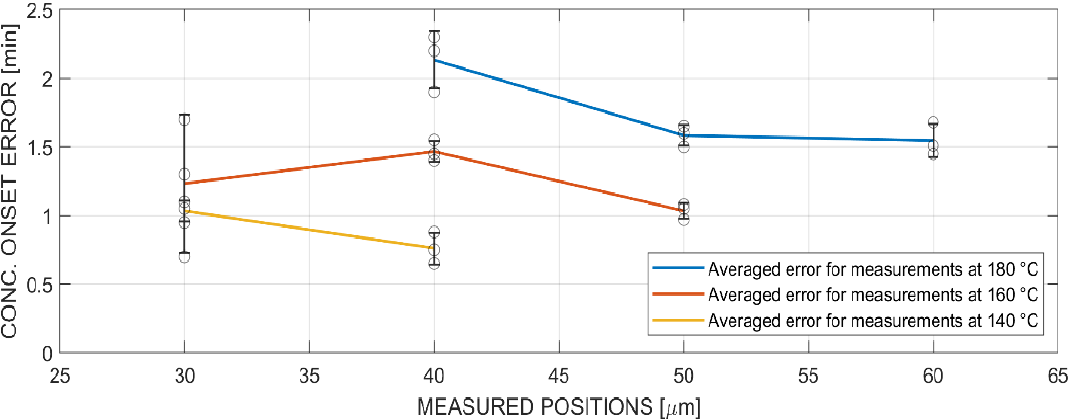
Figure 14. Comparison of the concentration onset error at 180 °C, 160 °C and 140 °C at different positions.